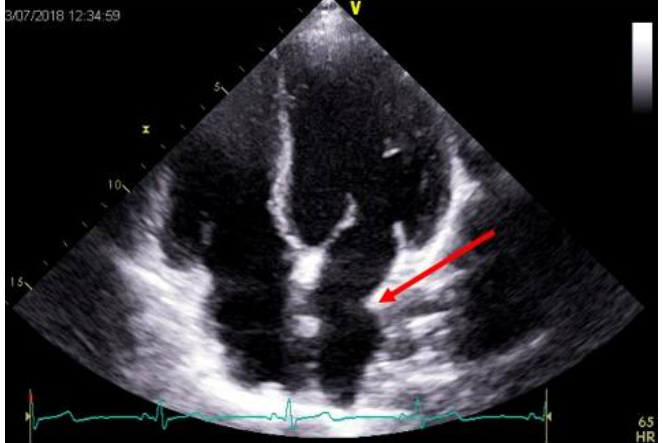
Figure 2. Apical four-chamber view, at trans thoracic echocardiography, after heart transplantation using a biatrial technique. Note the biatrial enlargement and the suture line in the left atrium that denotes the anastomosis between the donor and recipient atria (red arrow).